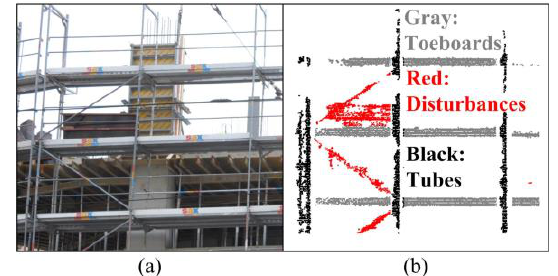
Figure 1. a) Real scene of scaffolds. b) Classification results of toeboards and tubes from generated point